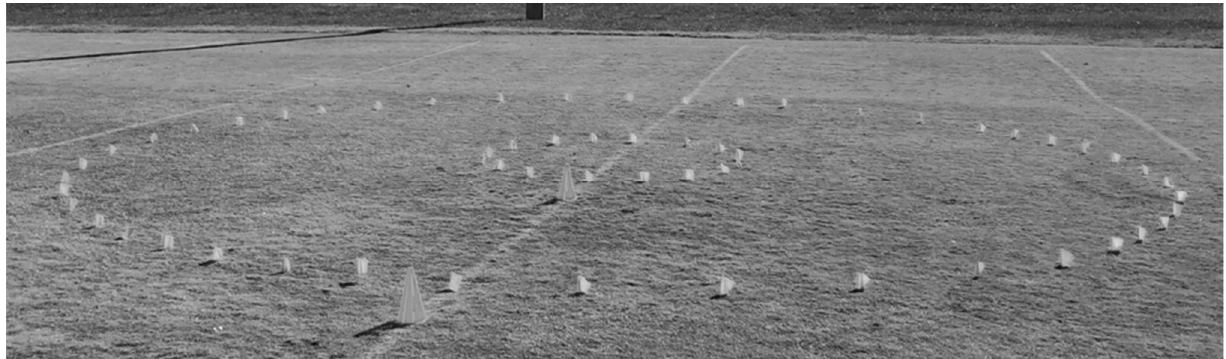
Figure 1. Design of the small and large circles.